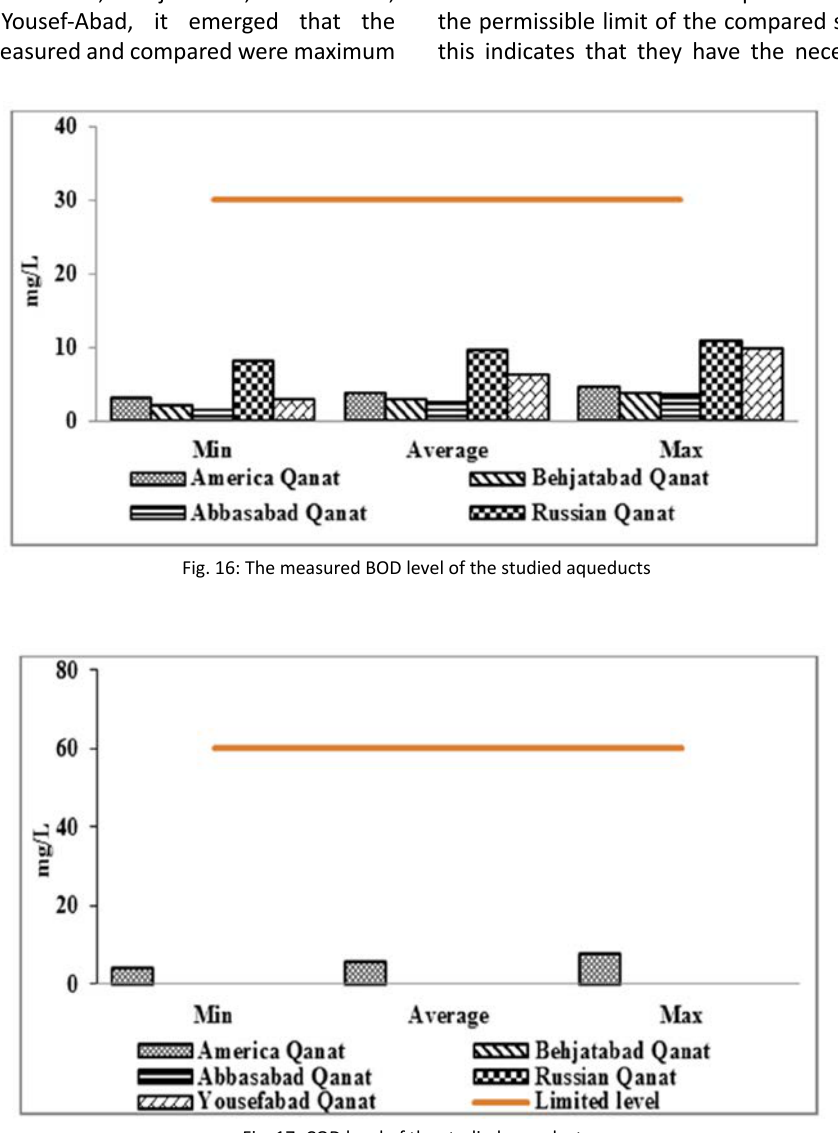
Fig. 17: COD level of the studied aqueducts